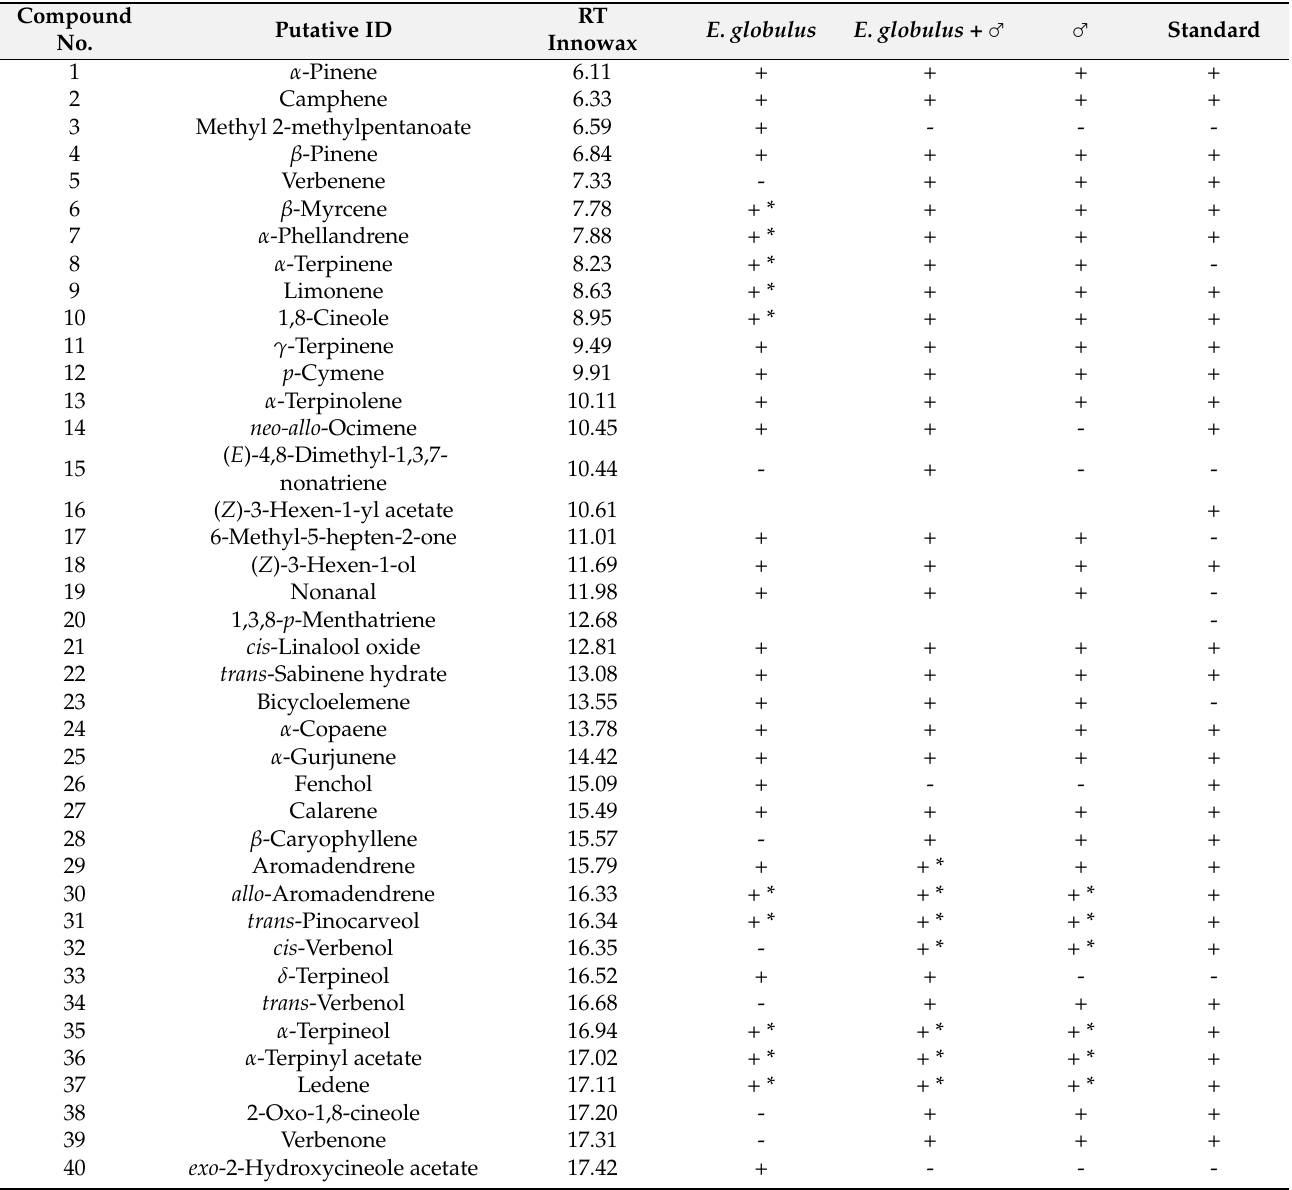
Table 1. Putative ID of the compounds inducing an EAG response by G. platensis, their retention time (RT) in an INNOWAX column (30 m × 0.25 mm i.d. × 0.25 µ m d f ), and presence, or absence, in the extracts used in GC/MS-EAD analysis. For each sample, co-elutions in the GC/MS-EAD operational conditions are signaled by *. Confirmation of compound identity and antennal activity by standard injection is indicated with a (+) sign in the “Standard” column. The (-) sign indicates that a Standard was not available to confirm compound identification and antennal activity. The presence or absence of each compound in the extracts used in GC/MS-EAD recordings was confirmed by GC × GC-FID and